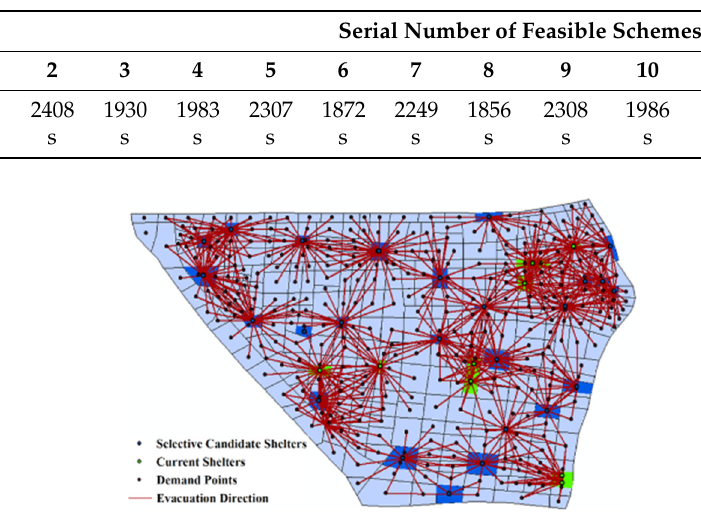
Table 5. The evacuation time of 15 feasible schemes.